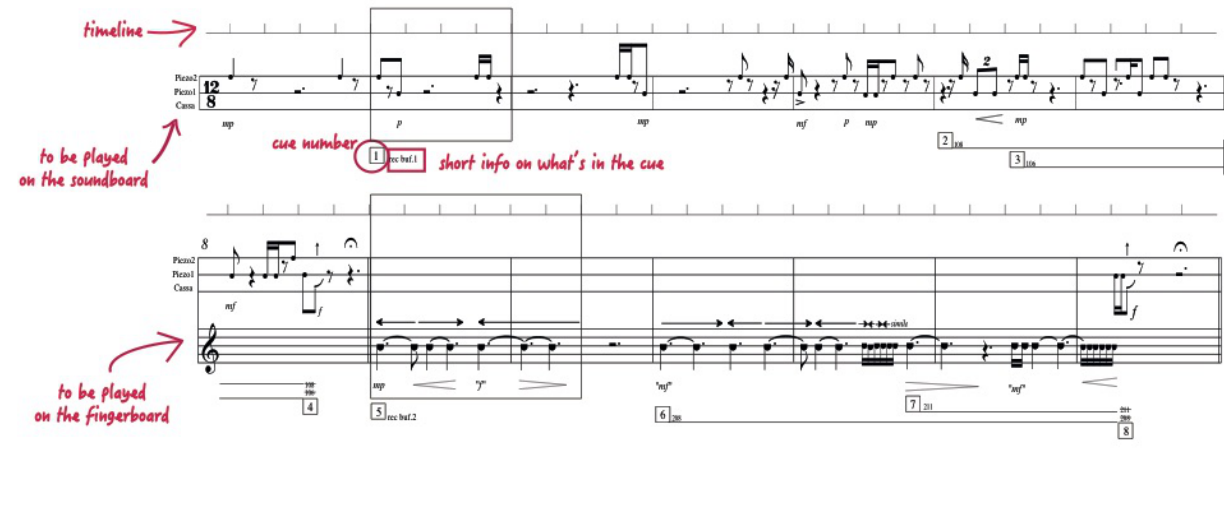
Figure 5 . Example from et ego